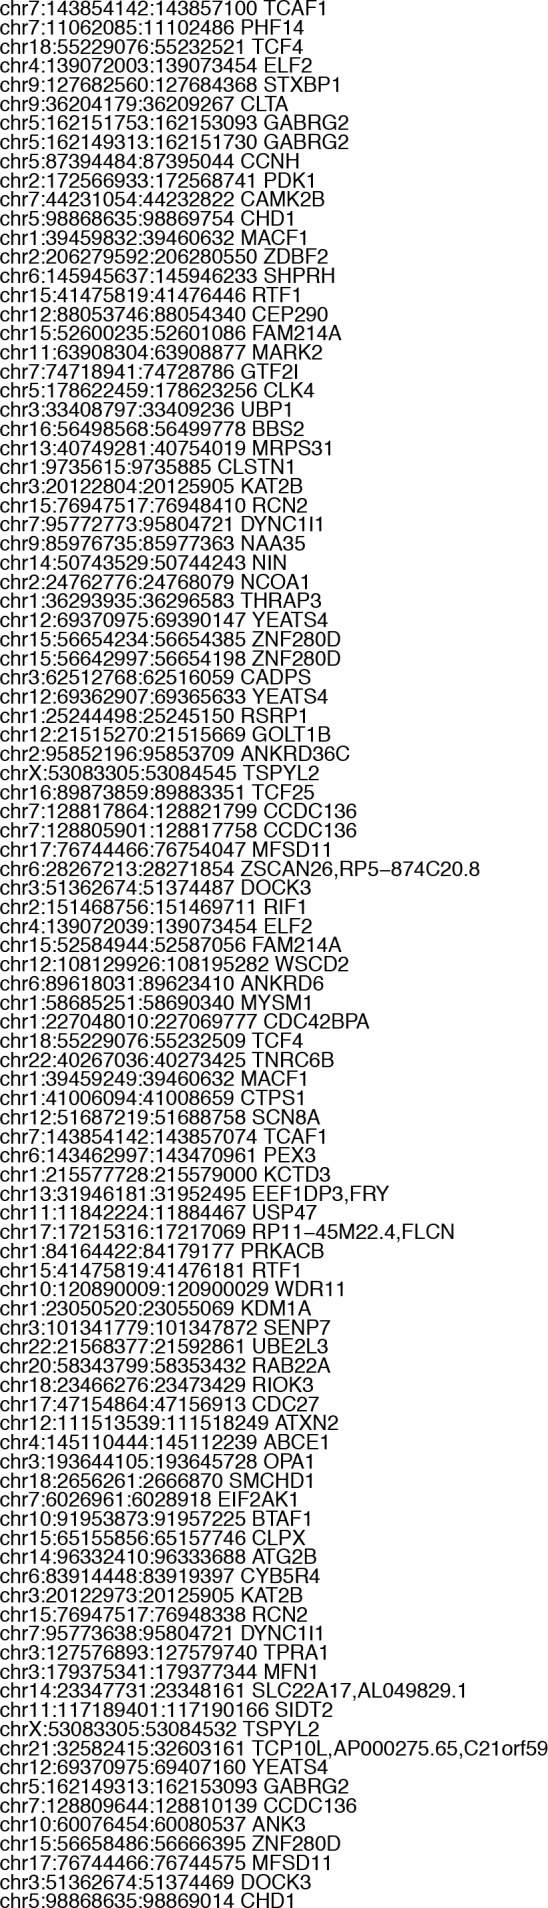
Events in Figure 6b heatmap as they appear in order.All coordinates are mapped to GRCh38/hg38.